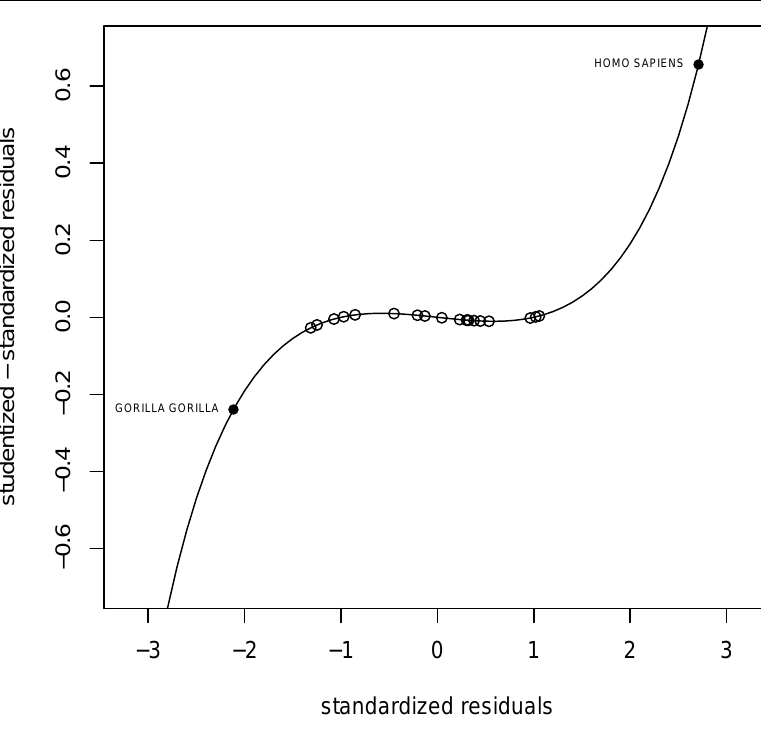
Figure 4 – Differences between studentized and standardized residuals vs. standardized residuals for the primates data. The solid line traces the deterministic relationship linking the plotted quan-